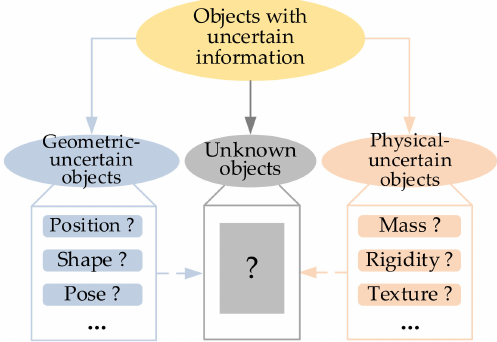
Figure 2. Classification of objects with uncertain